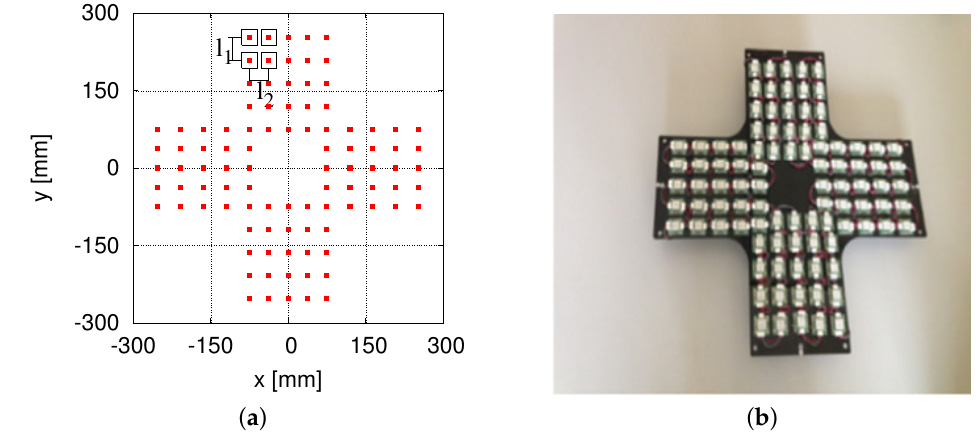
Figure 4. The 96 HF-band RFID readers. ( a ) Arrangement; ( b ) installation.